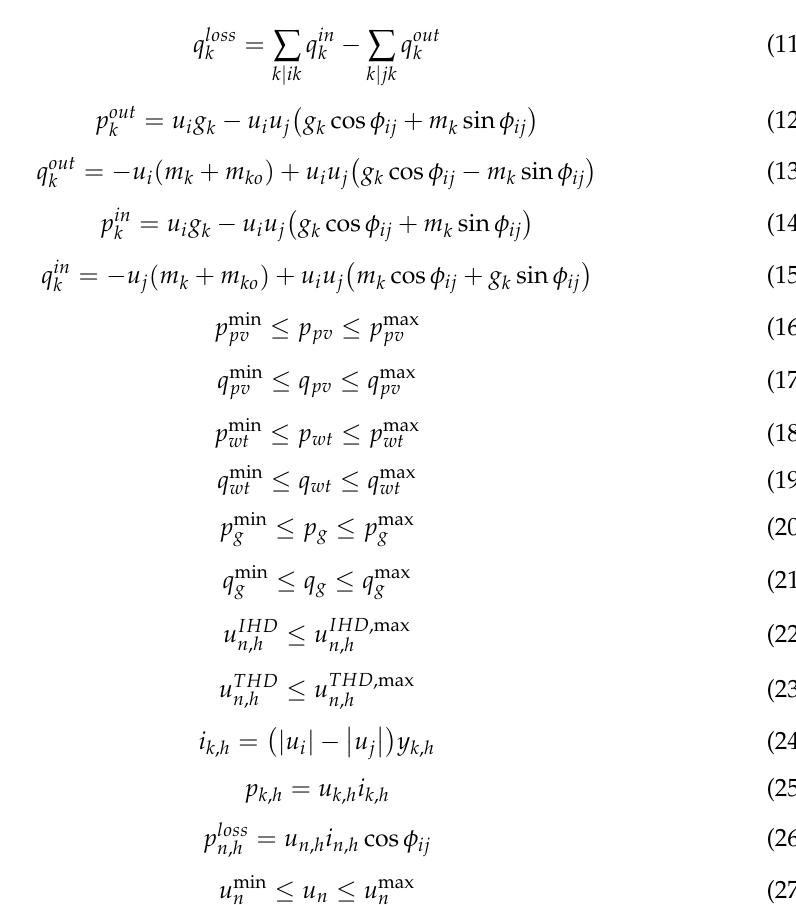
and q loss represent the real and reactive power k and q out represent the real and k